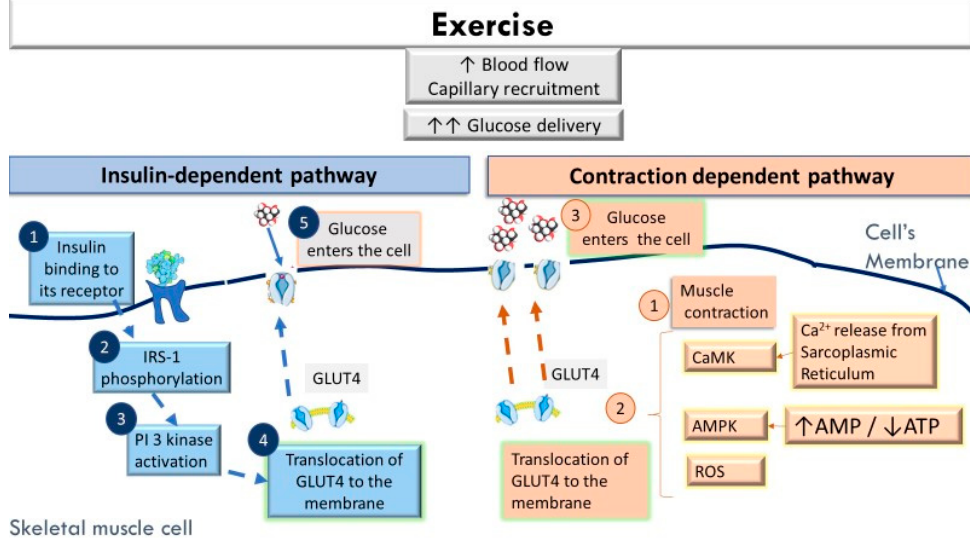
Figure 1. During exercise, the increase in skeletal muscle blood flow and capillary recruitment increase glucose delivery. Glucose uptake by the skeletal muscle cell is facilitated by two separate pathways: (i) an insulin-dependent pathway (which begins with insulin binding to its receptor (IRS), followed by its phosphorylation (1–2). In turn, the phosphoinositide 3-kinase (PI3K) pathway (3) is activated, and through a series of reactions, the translocation of GLUT4 to the cell membrane is stimulated (4)) and (ii) a contraction dependent pathway (which is mediated by several cellular events related to muscle contraction per se (1), such as the release of Ca 2+ by the sarcoplasmic reticulum to be used for muscle contraction and the activation the Ca 2+ /calmodulin-dependent protein kinase (CaMK), the reduction in the ATP/ADP ratio and the activation of AMP-protein kinase (AMPK), the transient increase in oxidative stress), which triggers the translocation of GLUT4 to the cell membrane. Although in insulin resistance states the insulin dependent pathway is dysfunctional, the contraction dependent pathway seems to remain intact. Therefore, exercise can promote greater glucose uptake and reduce hyperglycemia. A greater glucose uptake (vs. pre-exercise) remains in the post-exercise recovery period (depending on the characteristics of the exercise session). ROS: Reactive oxygen species; GLUT4: Glucose transporters 4.